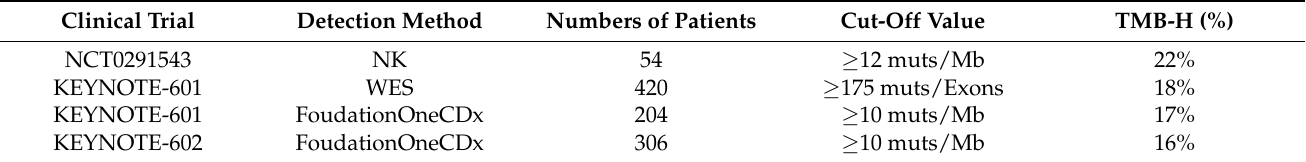
Table 2. The cut-off value of TMB in advanced gastric